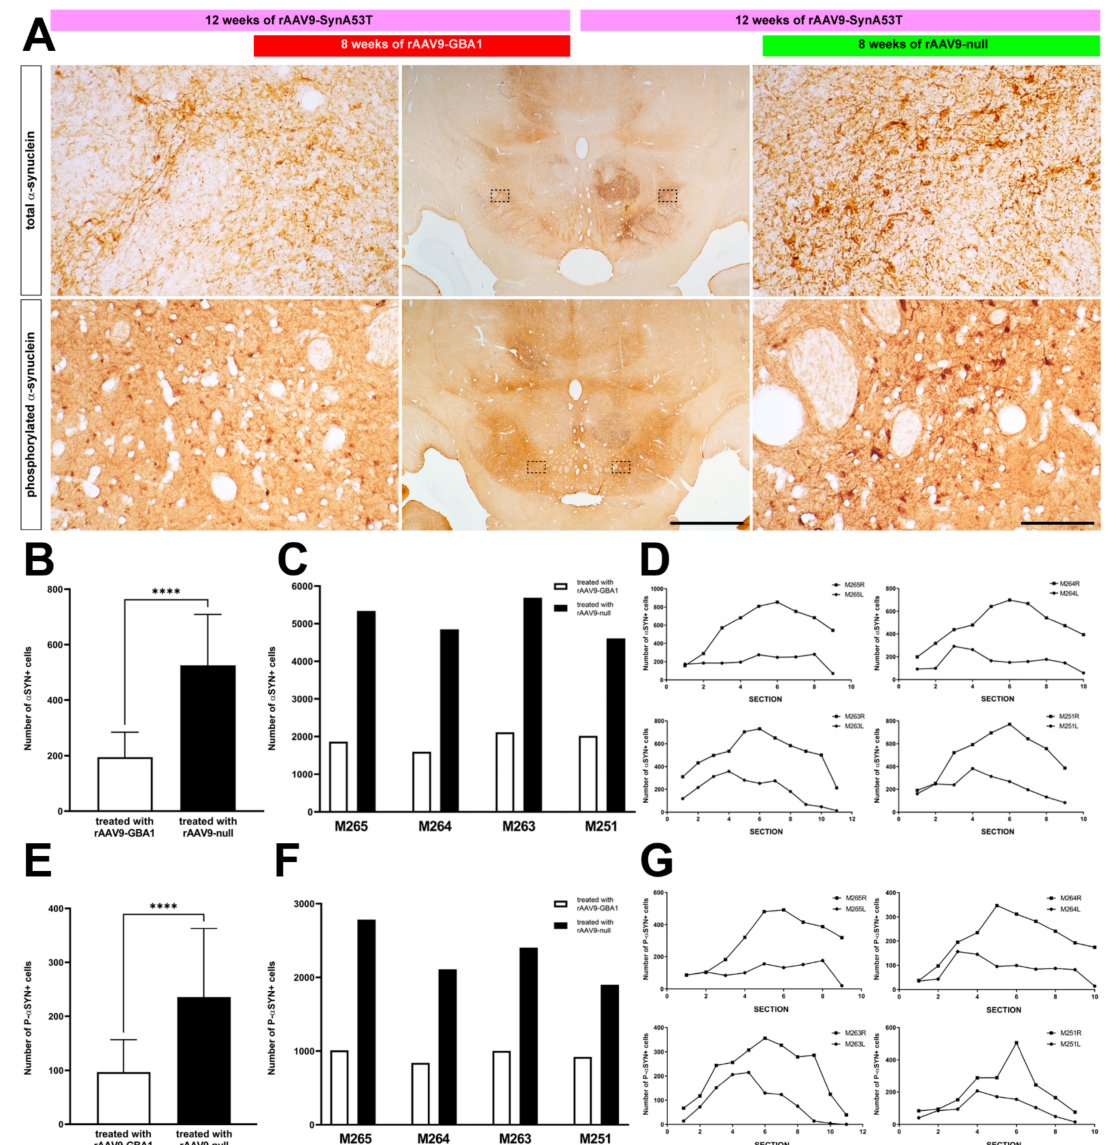
Figure 5. Immunohistochemical detection of α -syn in NHPs. ( A ) Coronal sections through the caudal mesencephalon taken at the level of the SNpc showing the obtained stains for total α -syn (top panels) and phosphorylated α -syn (bottom panels). Even at low magnification, there is a clear noticeable left vs. right difference in the obtained staining patterns. High-magnification insets showed a substantial reduction of α -syn burden in neurons and neurites within the left SNpc (e.g., the one treated with rAAV9-GBA1; left panels) when compared to the right SNpc (right panels). Scale bar is 2000 µ m for low-magnification photomicrographs and 200 µ m in insets. ( B ) Histogram showing reduced α -syn burden (e.g., number of α -syn+ cells) in the left SNpc compared with the right SNpc (white and black bars, respectively). ( C ) data gathered from each animal when considered individually. ( D ) The rostrocaudal extent of α -syn+ cells in the left vs. the right SNpc for all treated animals. ( E ) Histogram showing the reduction in phospho- α -syn+ cells in the left SNpc (e.g., the one treated with rAAV9-GBA1; white bar) compared to the SNpc treated with the control-null vector (black bar). ( F ) Data taken from each animal and ( G ) Rostrocaudal distribution of phospho- α -syn+ cells in all macaques. ****: p <